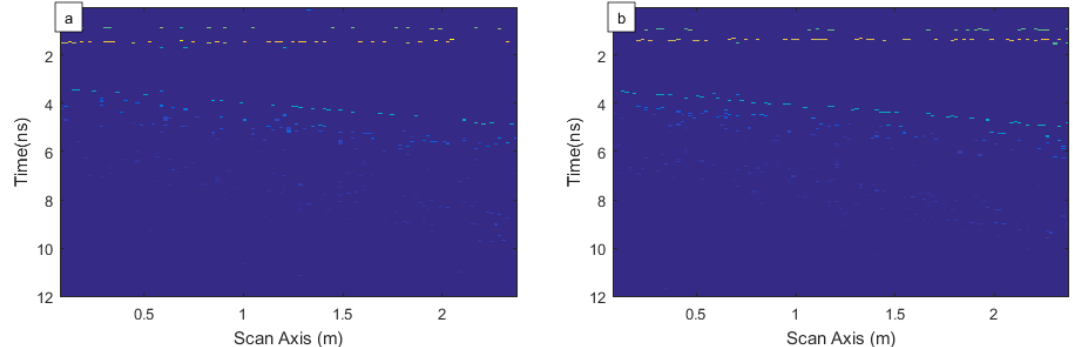
Figure 12. Frequency division section based on EMD: ( a ) frequency division section at 1.0 GHz; and, ( b ) frequency division section at 1.2 GHz.